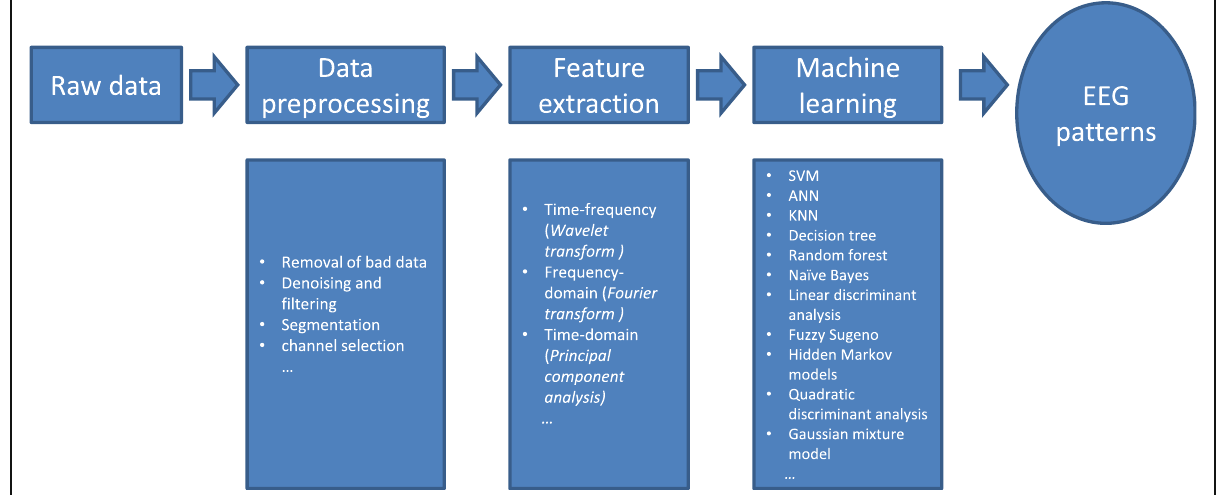
Fig. 2 General steps for EEG processing. “ Feature extraction ” is referred to a straightforward data procession to draw hidden information of raw EEG signals from the available channels (frequency contents or spatial connectivity). Feature is divided into univariate features (e.g. spectral power) and bivariate feature (e.g.